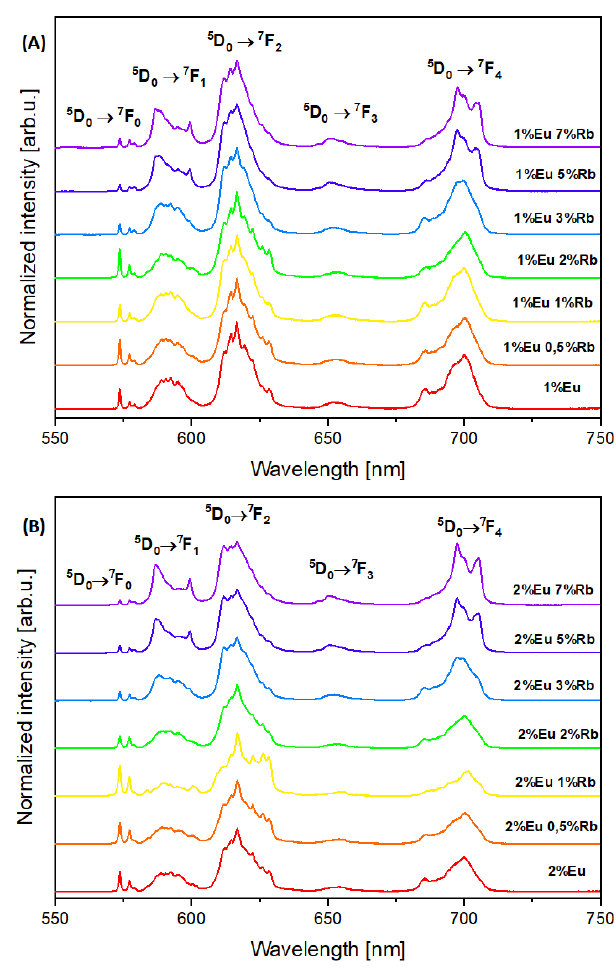
Figure 5. Emission spectra of ( A ) Ca 10 − (0.1 + x) Eu 0.1 Rb x (PO 4 ) 6 (OH) 2 and ( B ) Ca 10 − (0.2 + x) Eu 0.2 Rb x (PO 4 ) 6 (OH) 2 , where x equals 0.5, 1, 2, 3, 5, 7 mol% of Rb + ions.